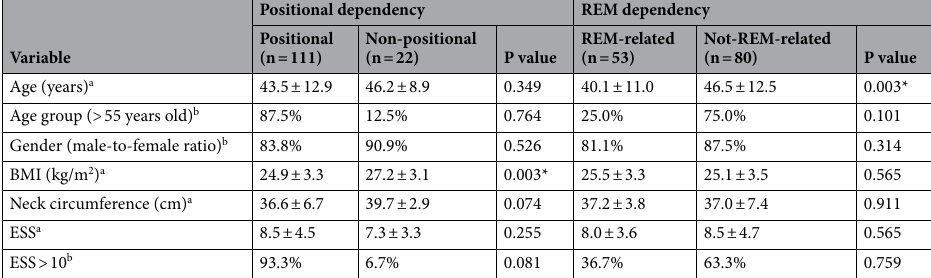
Table 1. Demographic features according to positional and REM dependency. REM, rapid eye movement sleep; BMI, body mass index; ESS, Epworth sleepiness scale. a Results were obtained from independent T-test: mean ± SD. b Results were obtained from Chi-square test. *Significant difference: p <